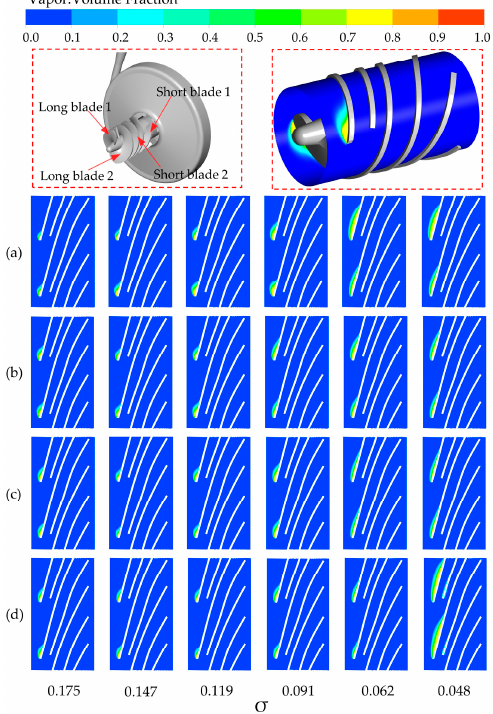
Figure 8. Vapor phase volume fraction distribution of the shunt blade inducer under different TCs